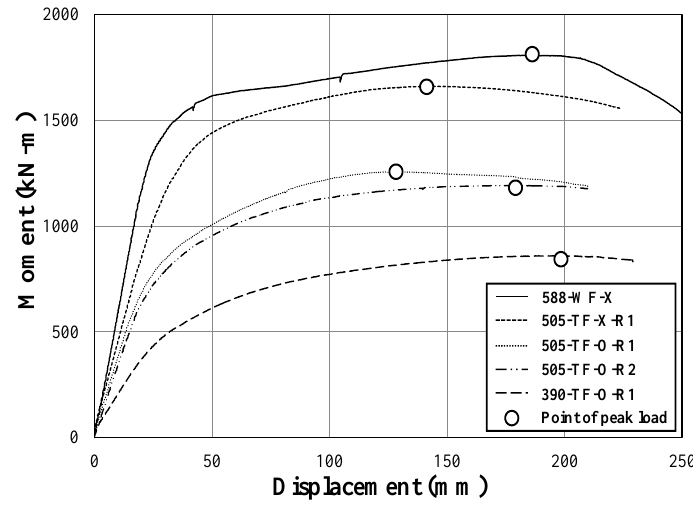
Figure 12. Load versus displacement curves of the non-composite specimens.